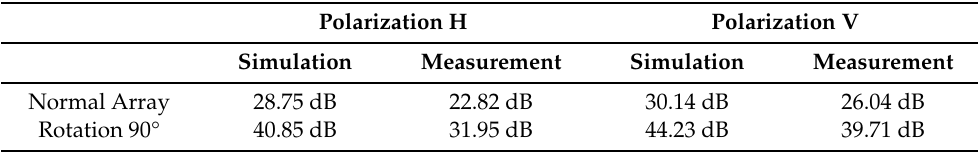
Table 8. Comparison of cross-polarization suppression @ f 0 = 1.325 GHz. Beamforming.